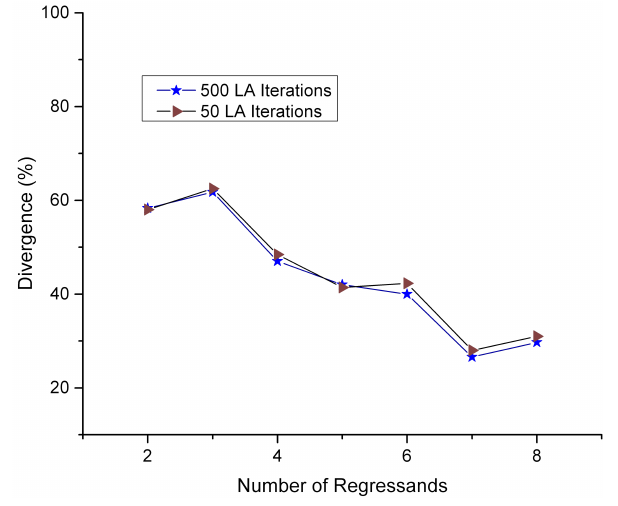
Figure 9. Percentage of divergence of Orion in contrast to random sequences of